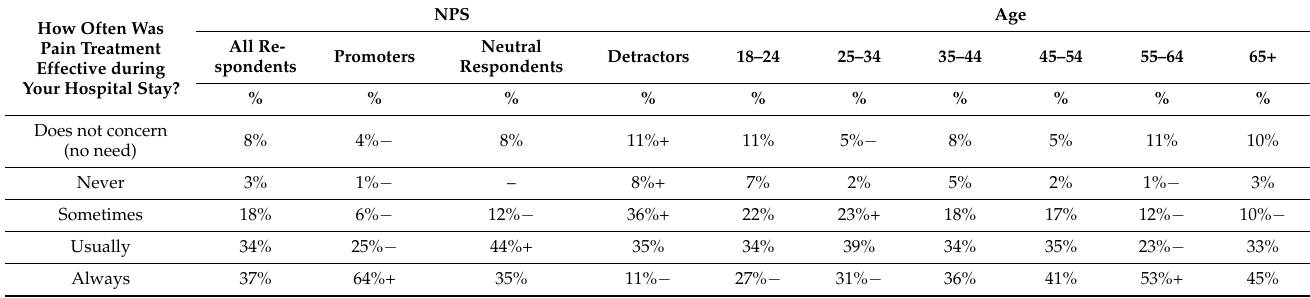
Table 5. Analysis of how often pain treatment in hospital was